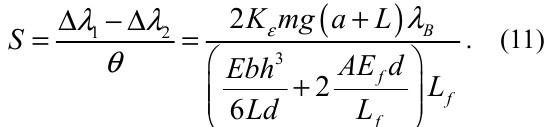
Fig. 4 Deformation process of the